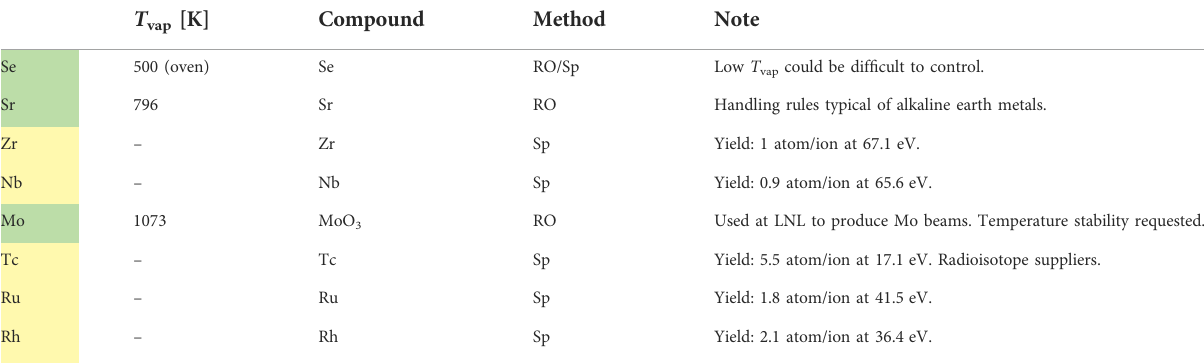
TABLE 1 Light r -process elements of interest for opacity measurements for the blue-KN stage. T vap [K] is the evaporation temperature of the species. Species with larger injection ef fi ciency and easier production are marked in green ( ▪ ), while those presenting some ef fi ciency or availability limitations in yellow ( ▪